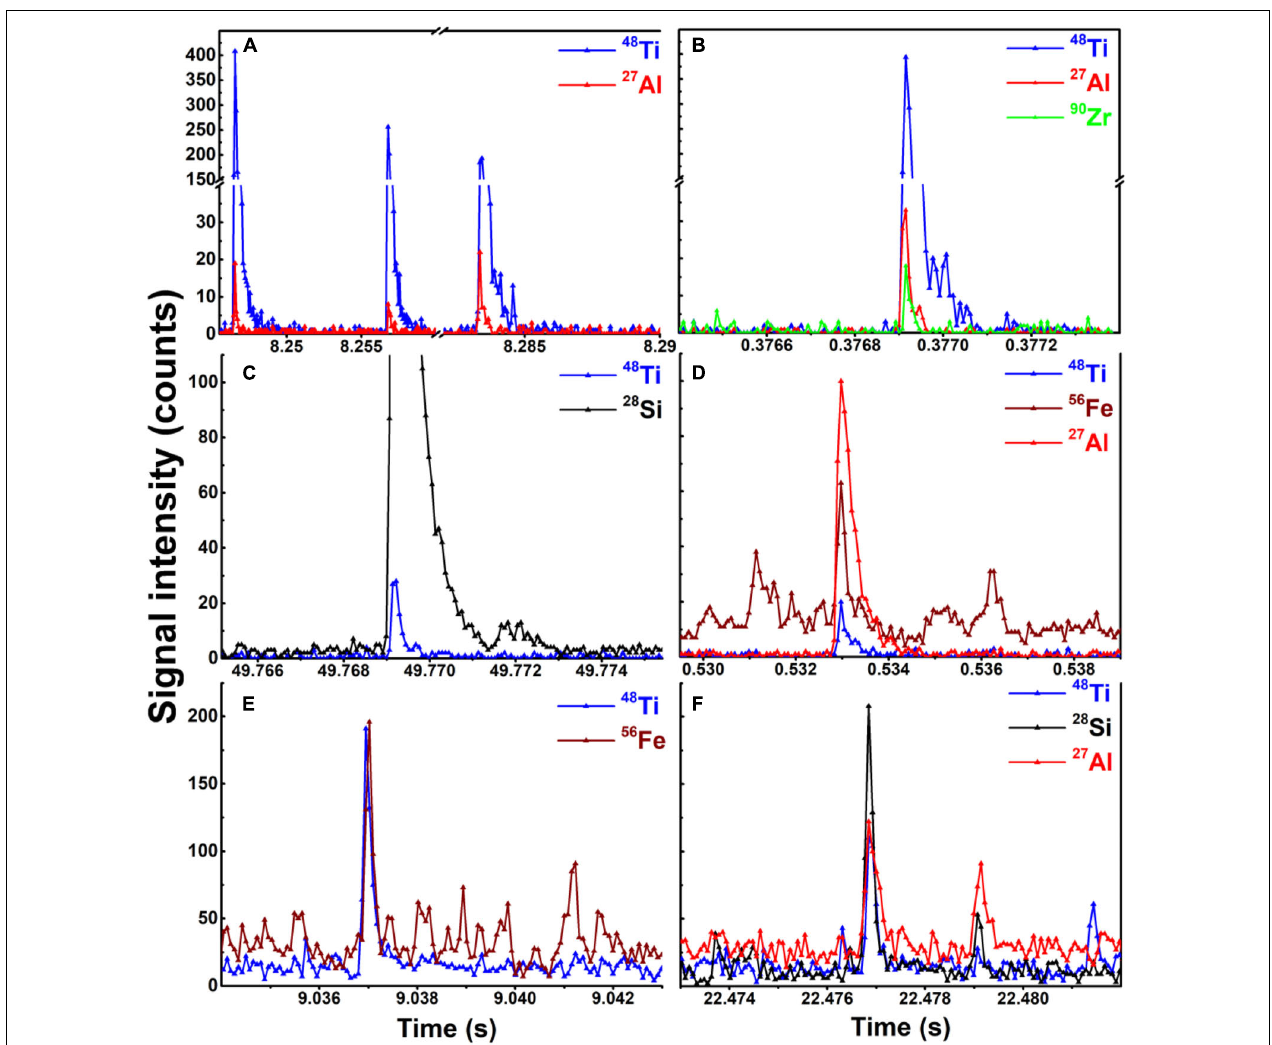
FIGURE 5 | Examples of SP-ICP-TOF-MS raw peak data corresponding to Ti-containing NPs detected in the different matrices. Association of Ti with (A) Al or with (B) Al and Zr in the liquid paint. Association of Ti with (C) Si or with (D) Fe and Al in the liquid stain. Association of Ti with (E) Fe and (F) Si and Al in Montreal rain.